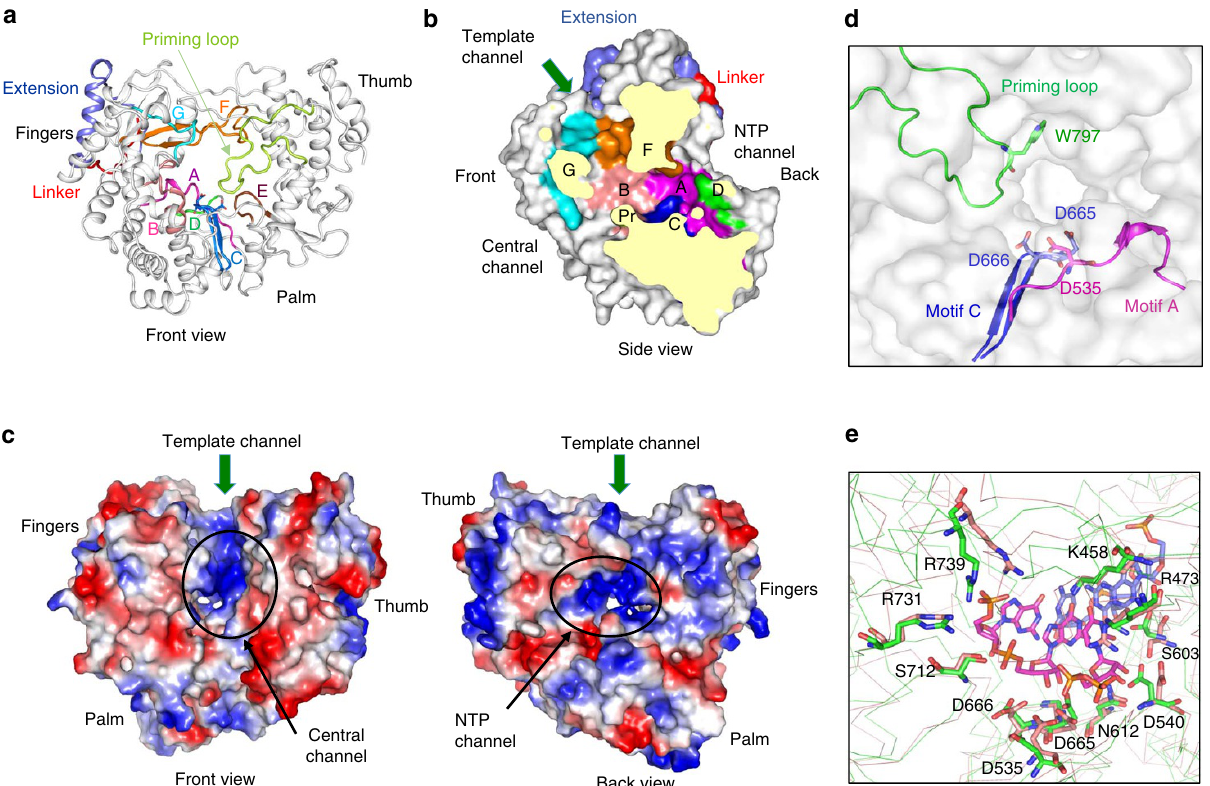
Figure 4 | Structure of ZIKV RNA-dependent RNA polymerase domain (RdRp). ( a ) Ribbon representation of the RdRp showing the locations of structural motifs that are critical for RNA synthesis. The extension (slate) is a unique structure of flaviviral NS5 connecting the RdRp with the MTvia the linker. The priming loop (lime) extending from the thumb subdomain, forming a platform to coordinate with the NTP for polymerization. ( b ) Cut-away surface representation of ZIKV RdRp showing the locations of the template channel, the central channel and the NTP channel. Motifs G and F that form the encircled active site and also a constriction in the template channel are coloured cyan and orange. The priming loop is identified by ‘Pr’. Motif C and A that bind divalent metal ions are coloured blue and purple. ( c ) Electrostatic surface of ZIKV RdRp in two orientations. Positively charged surface is coloured blue and negatively charged surface red. ( d ) Locations of the key residues in the priming loop and active site of ZIKV RdRp. ( e ) Superposition of HCV RdRp (salmon) in complex with template RNA (slate sticks) and the initiation NTP (purple sticks, PDB, 4WTL) with ZIKV RdRp (green). Conserved residues of ZIKV RdRp are shown by the green